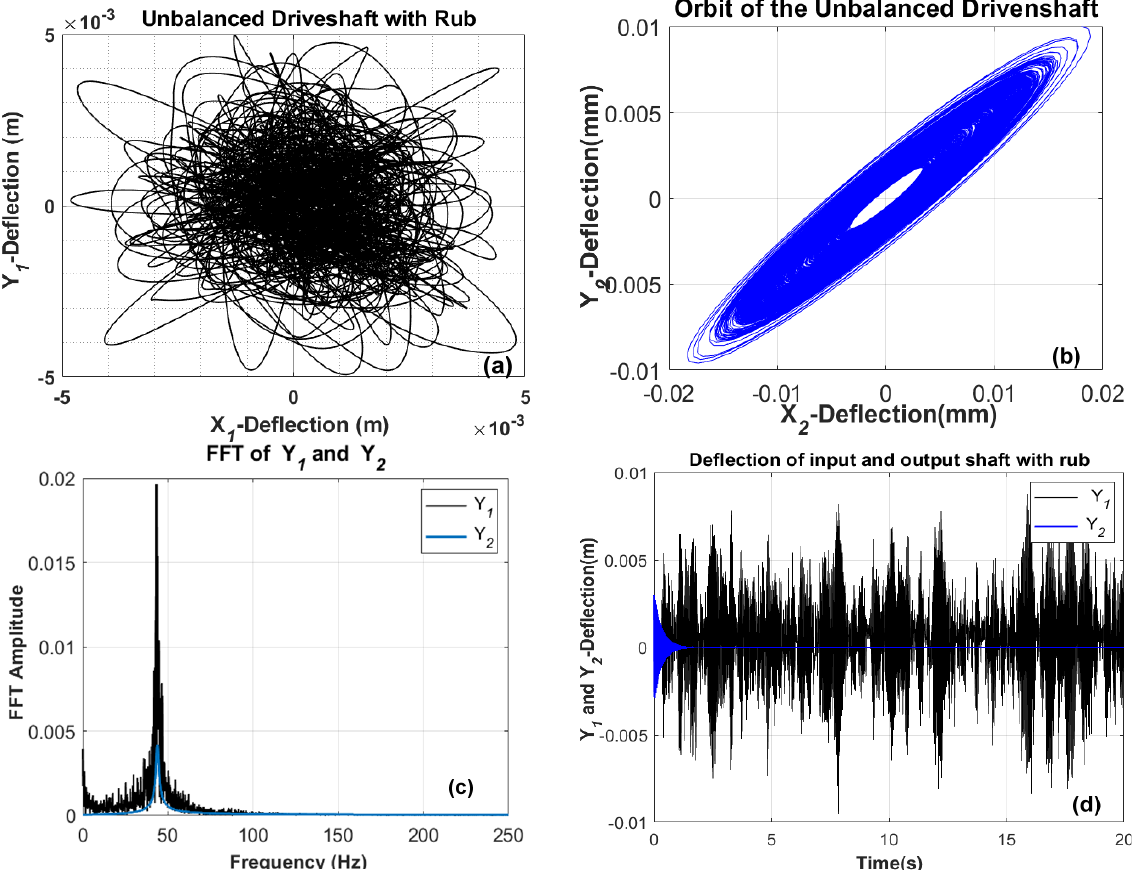
Figure 9. Dynamic response of driveline rotors with driveshaft ‐ to ‐ stator rubbing ( a , b ) orbit of the input and output unbalanced shafts ( c ) Fast Fourier Transform spectrum response ( d ) transient deflection response of shafts.